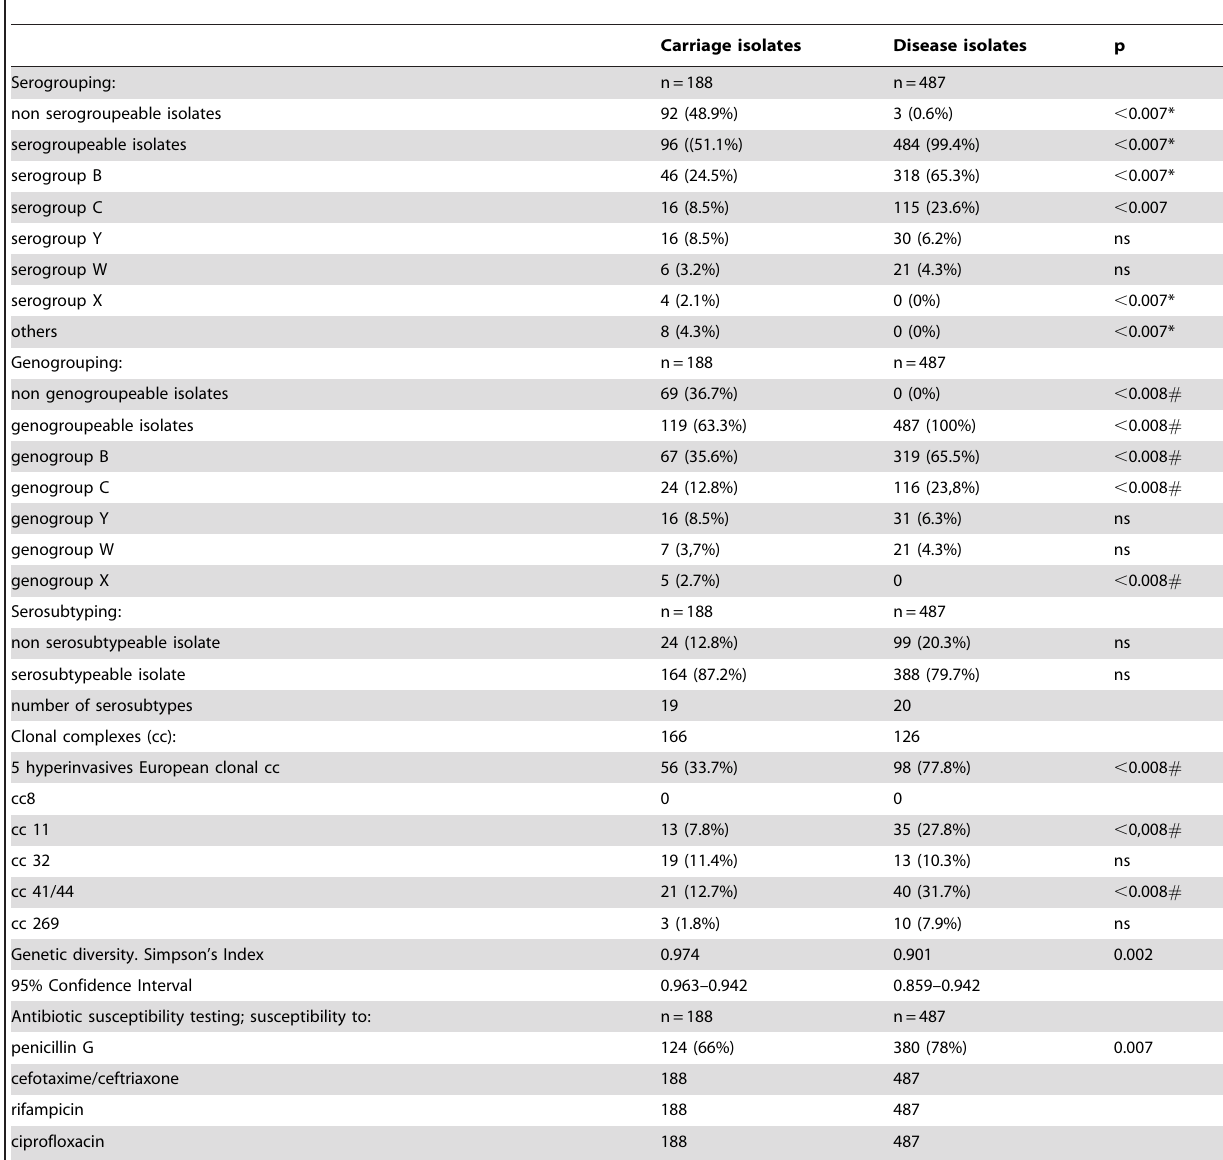
Table 1. Overall phenotypic and genotypic diversity of N meningitis isolates from France in 2008, either from healthy carriers (i.e., carriage isolates) or from cases of invasive meningococcal disease (i.e., invasive